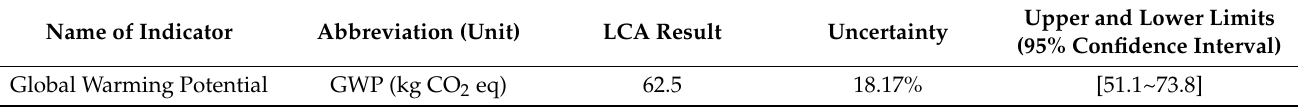
Table 5. Carbon footprint results and uncertainties of magnesium salt leaching